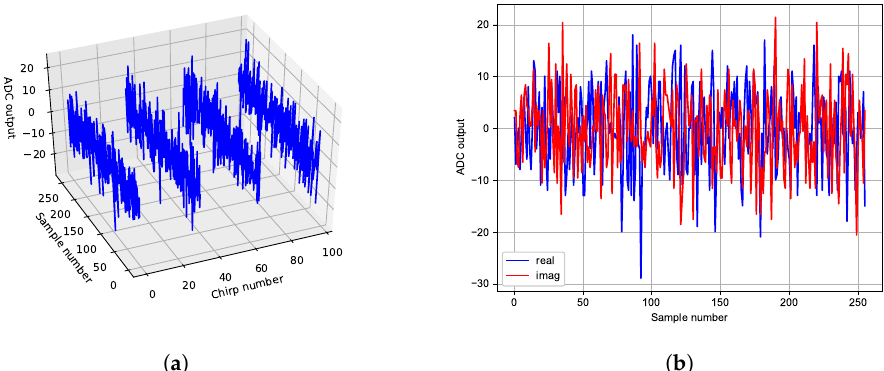
Figure 7. ( a ) Real part of the system noise for 4 chirps. ( b ) Real and imaginary parts of the system noise for a single